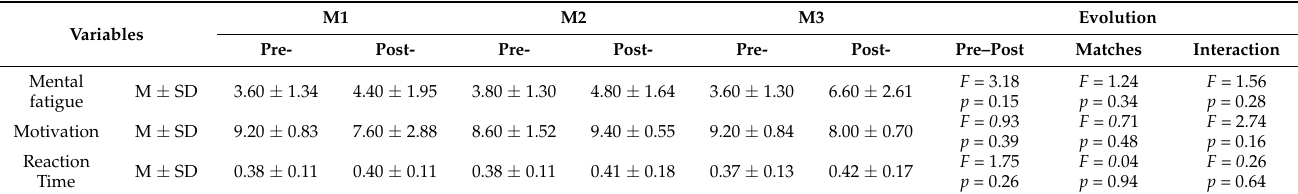
Table 2. Mental fatigue, motivation and reaction time from pre- to post-three match evolution ( n = 6). M1 M2 M3 Evolution Variables Pre- Post- Pre- Post- Pre- Post- Pre–Post Matches Interaction Mental fatigue Reaction